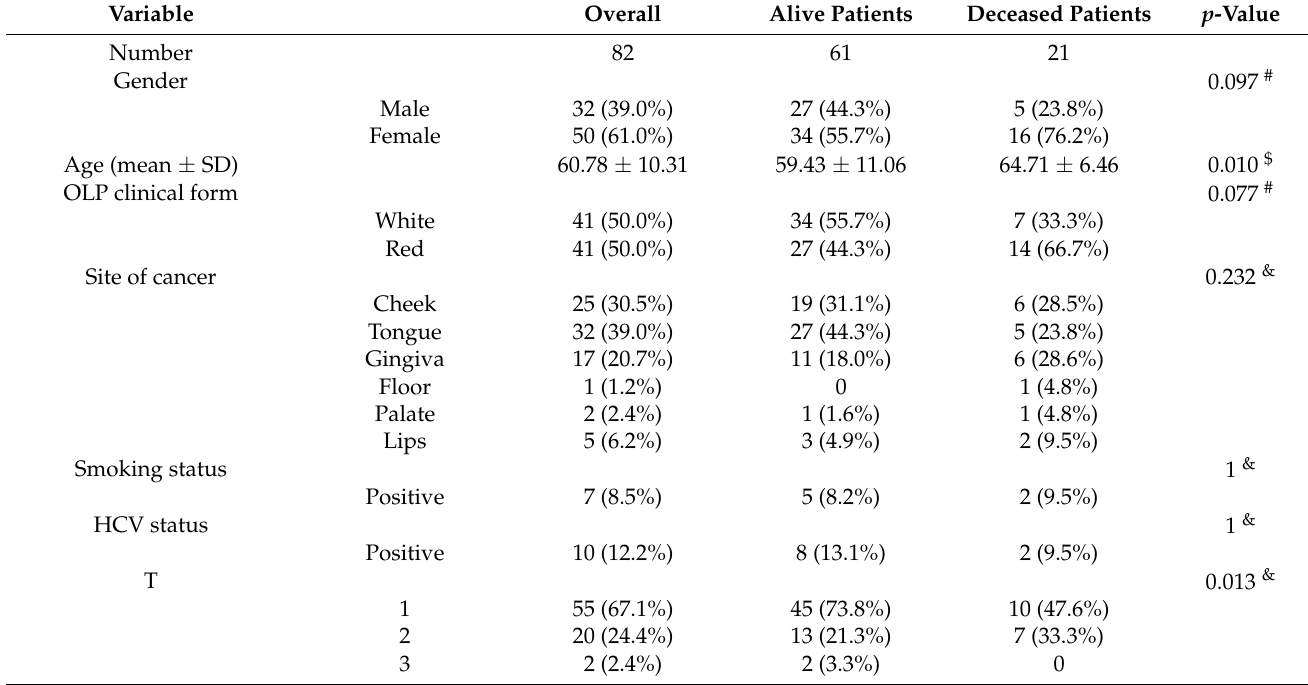
Table 2. Demographic and clinical features of patients who developed a malignant transformation. Variable Overall Alive